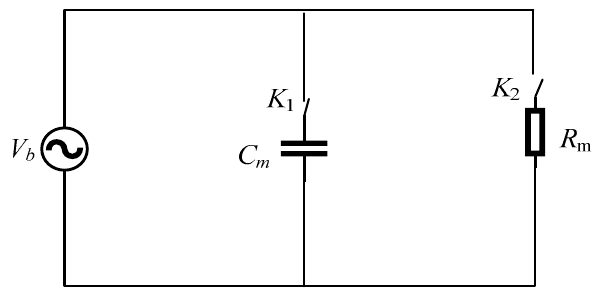
Figure 6. Improved bearing equivalent breakdown model.